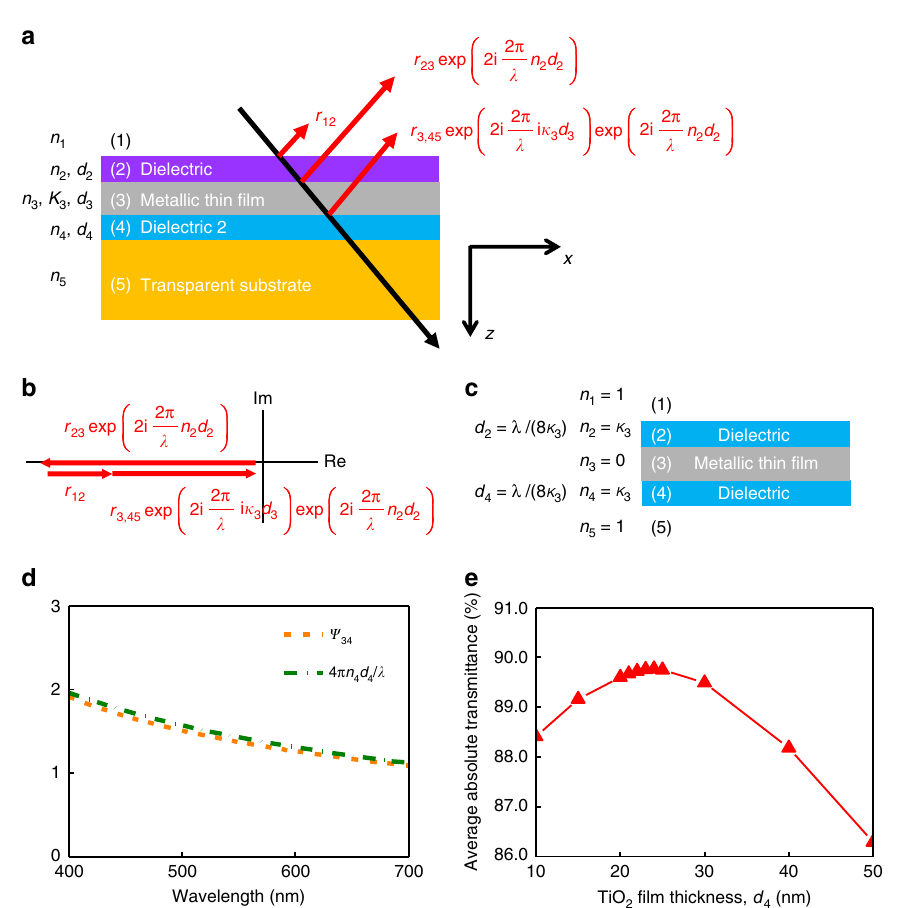
Fig. 2 Theoretical design of a DMD electrode. a Design parameters and re fl ection waves at various interfaces of a DMD transparent electrode. b Phasor diagram of re fl ection waves. c An ideal DMD and its parameters. d The calculated values of the left and right terms in Eq. (9) when using 24 nm TiO 2 and 9 nm Ag as Dielectric 2 and the metallic layer, respectively, in the DMD structure, showing that Eq. (9) is well satis fi ed across the entire visible range. e Optimal averaged transmittance of the DMD electrode across the visible range (400 – 700 nm) dependent on the thickness of Dielectric 2. Here, TiO 2 and 9 nm Ag are used as the bottom dielectric layer and the middle metallic layer, respectively. Each optimal transmittance value at a fi xed TiO 2 thickness is found out by sweeping the refractive index ( n 2 ) and the thickness ( d 2 ) of Dielectric